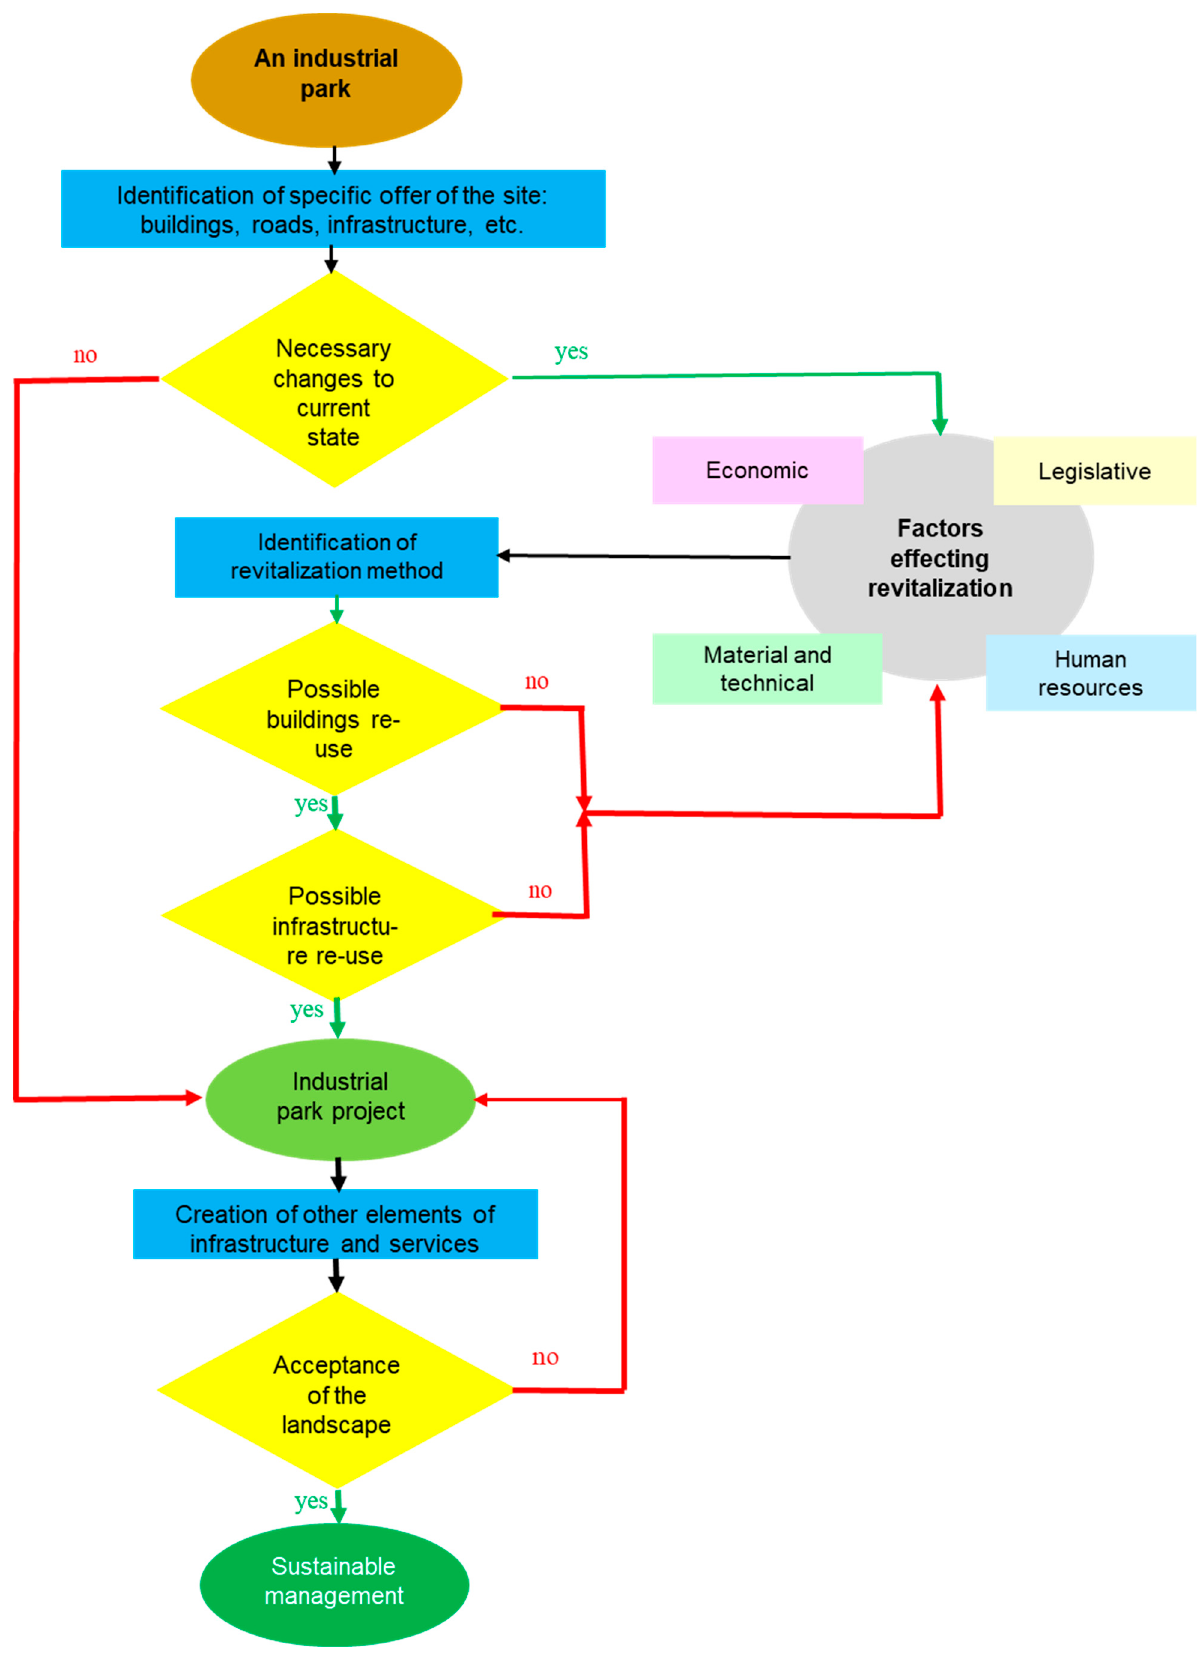
Figure 2. Model of industrial park investment projects management.